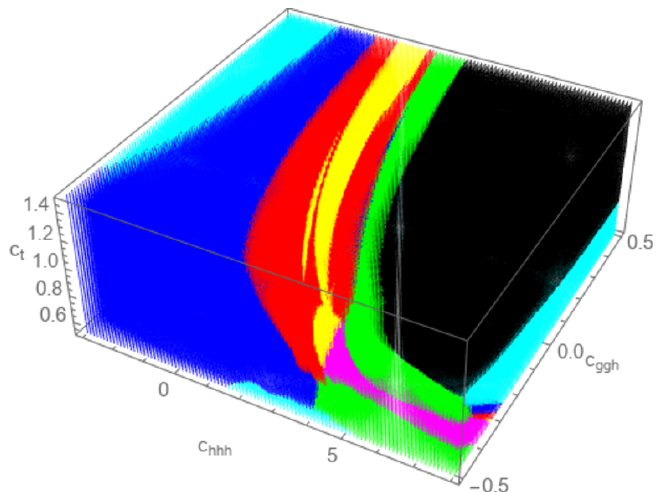
Figure 18 . Three-dimensional visualisation of shape types produced by variations of c t , c hhh and c ggh simulating the SMEFT situation. For c gghh the value given by eq. (2.4) has been used, for c tt we used c tt = 0 : 05 c t